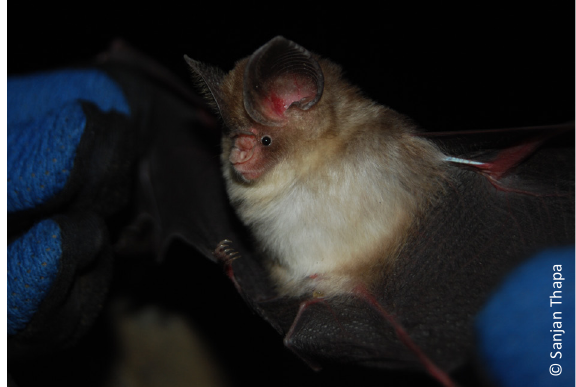
Image 10. Fishing Cat Prionailurus viverrinus